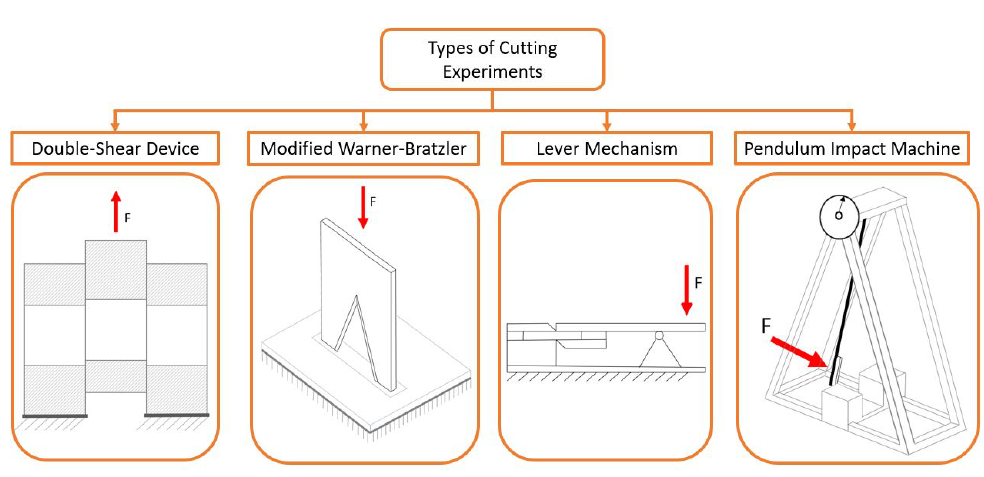
Figure 1. Types of cutting experiments found in the